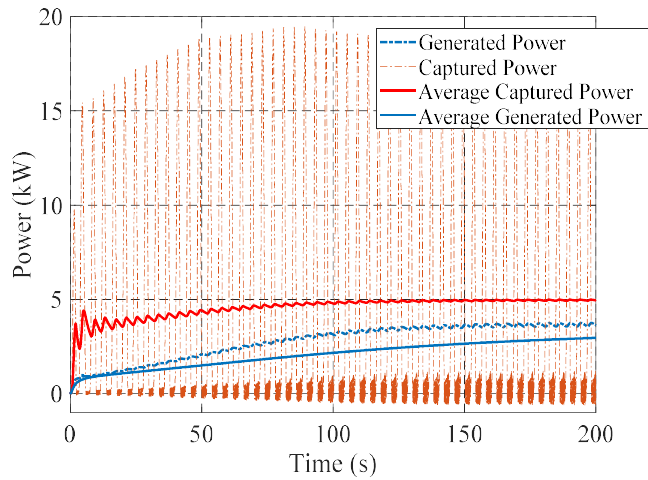
Figure 12. The power of hydraulic PTO. The blue line is generated power, which is the power output from the hydraulic motor. The red line is the captured power, which is the power from the buoy to hydraulic system. The generated power with friction is 3.8 kW.